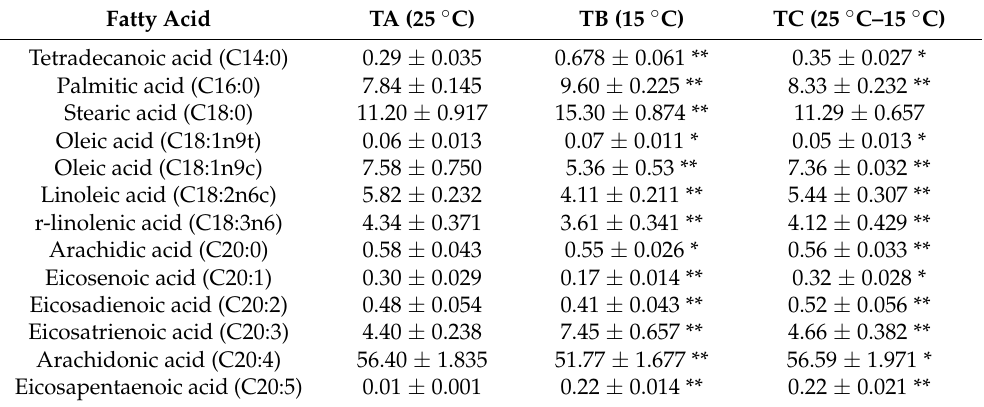
Table 2. Effects of temperature on the fatty acid composition (%) in the total lipids of three groups (i.e., TA, TB, and TC) of Mortierella alpina under three different temperatures. The condition “25 ◦ C–15 ◦ C” indicates the temperature first at 25 ◦ C and then at 15 ◦ C. The symbols “*” and “**” indicate significant differences set at p -values of 0.05 and 0.01, respectively, in comparison to the TA group. Fatty Acid TA (25 ◦ C) TB (15 ◦ C) TC (25 ◦ C–15 ◦ C) Tetradecanoic acid (C14:0) 0.29 ± 0.035 0.678 ± 0.061